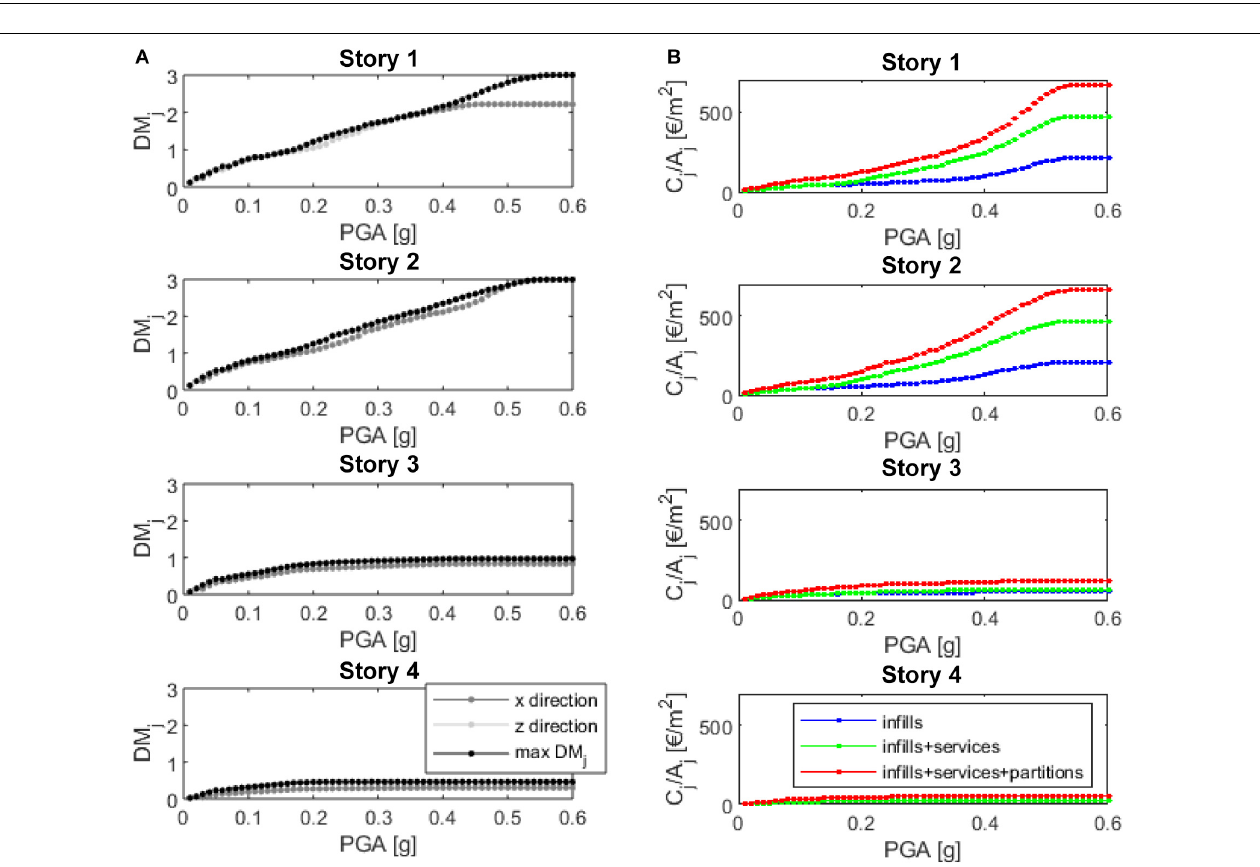
FIGURE 9 | Story-mean damage (DM j ) (A) and story-repair cost (C j ) divided by story-surface area (A j ) (B) depending on PGA–GLD-4 case study.